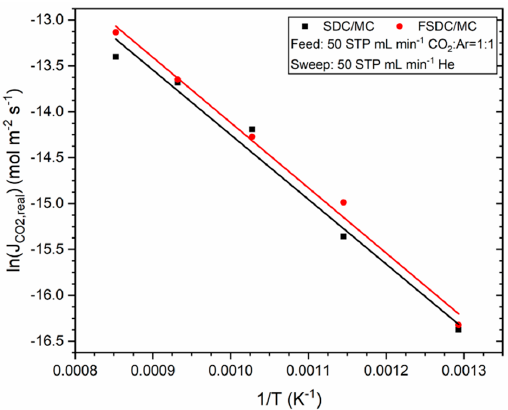
Figure 7. Arrhenius Equation fit displaying the ln of the CO 2 flux density as function of the inverse of the temperature for the SDC and FSDC DP membranes.